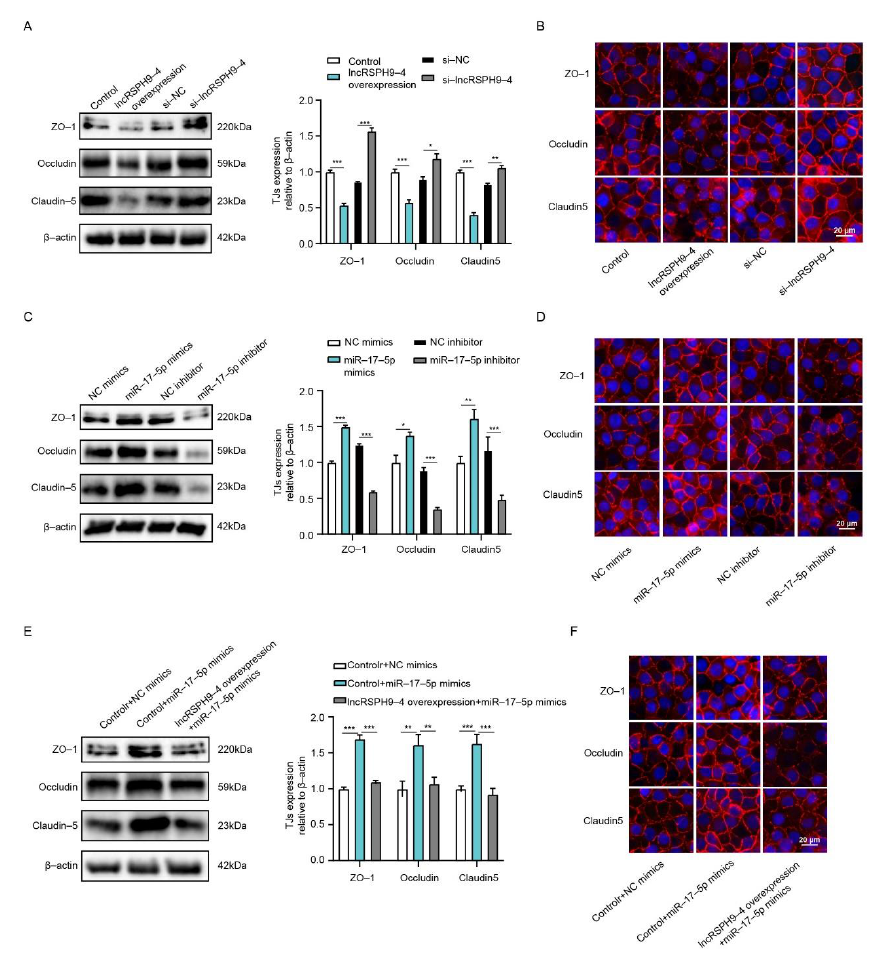
Figure 7. LncRSPH9-4 overexpression decreased TJs expression via miR-17-5p . ( A ) The expression of TJs in hBMECs with lncRSPH9-4 overexpression or silencing by Western blot analysis. β -actin was used as the loading control and densitometry was performed to analyze differences. * p < 0.05, ** p < 0.01 and *** p < 0.001. ( B ) Distribution of TJs in hBMECs with lncRSPH9-4 overexpression or silencing by immunofluorescence analysis. ( C ) The expression of TJs in hBMECs with miR-17-5p overexpression or inhibition by Western blot analysis. β -actin was used as the loading control and densitometry was performed to analyze differences. * p < 0.05, ** p < 0.01 and *** p < 0.001. ( D ) Distribution of TJs in hBMECs with miR-17-5p overexpression or inhibition by immunofluorescence analysis. ( E ) The expression of TJs in miR-17-5p -overexpressed hBMECs co-transfected with or without lncRSPH9-4 by Western blot analysis. β -actin was used